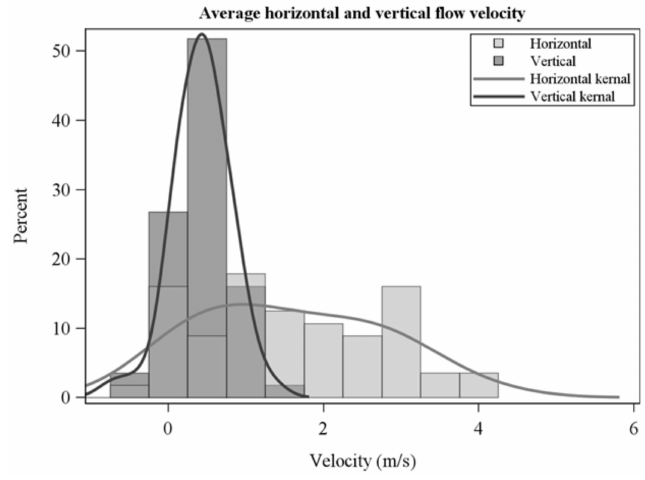
Figure 5. Horizontal and vertical velocities averaged over residence times.